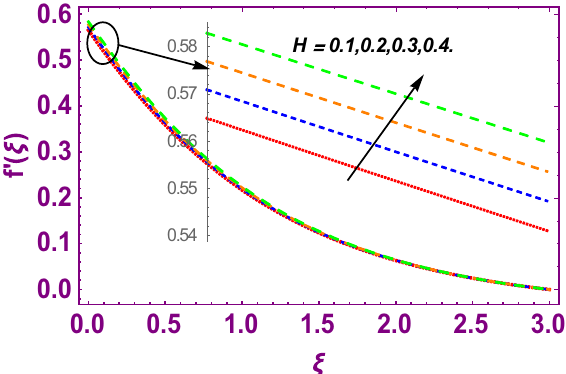
Figure 5. Effect of H on f ′ (ξ) .